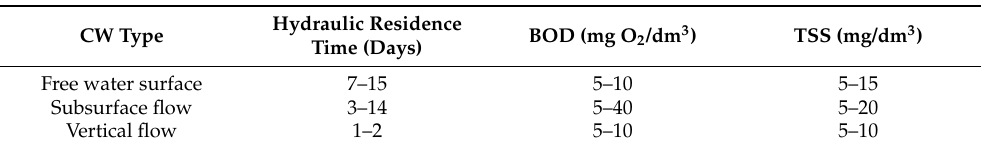
Table 5. Average values of the concentration of organic matter (BOD) and suspended solids (TSS) in the outflow of the three basic types of CW